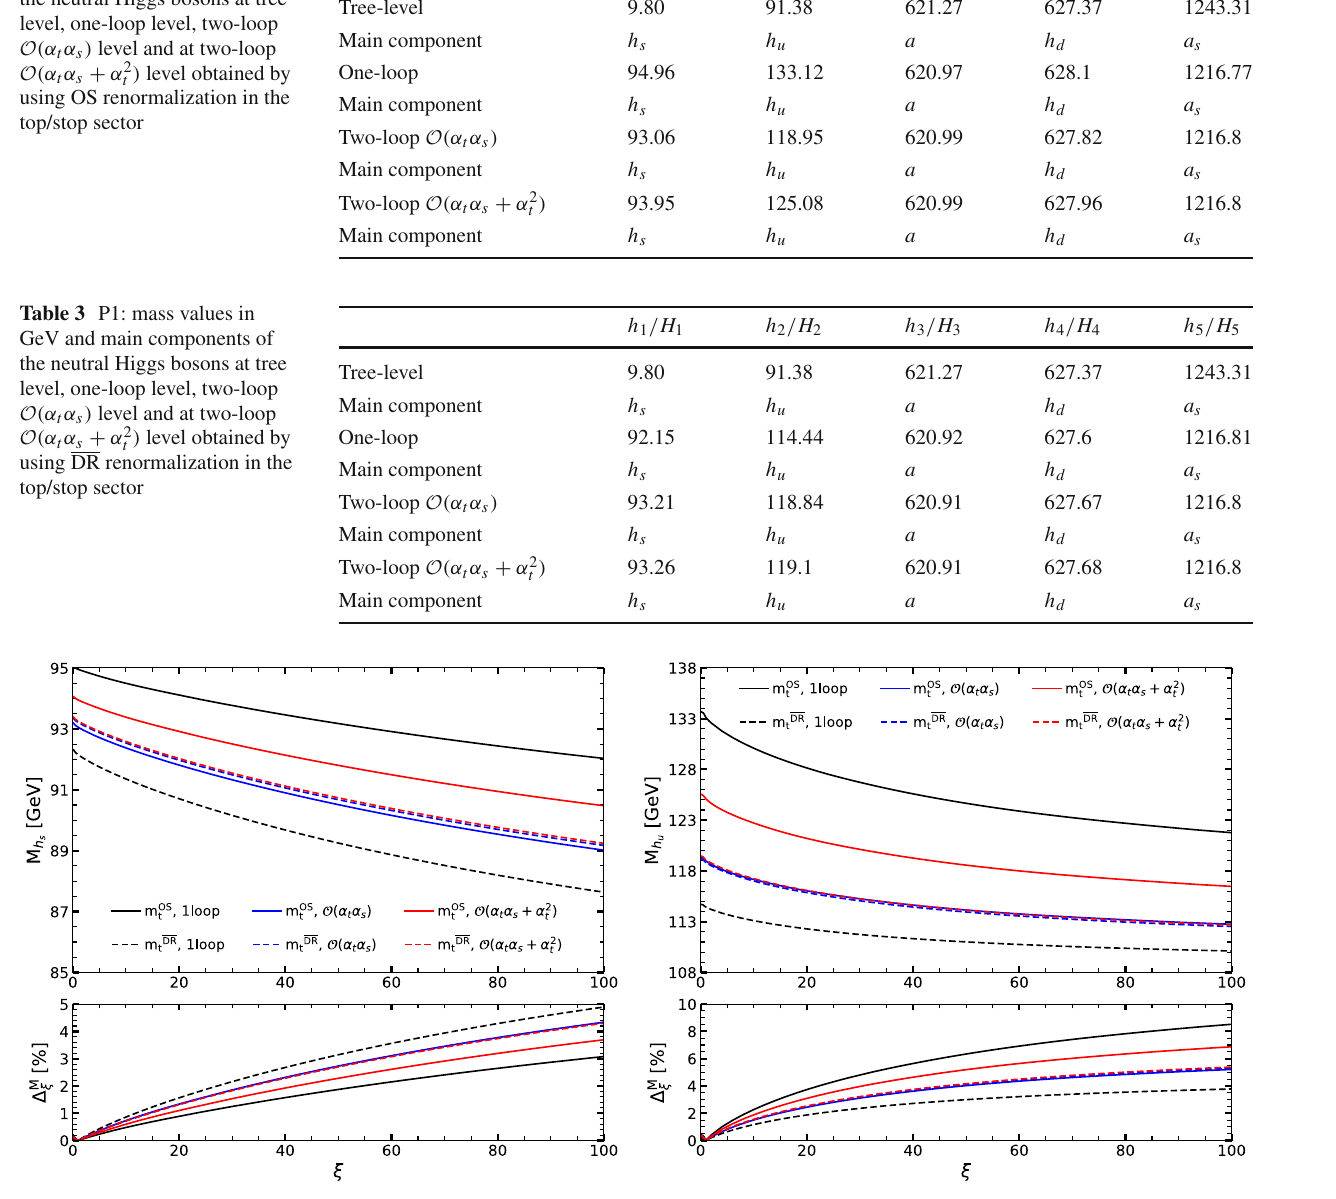
Table 2 P1: mass values in GeV and main components of the neutral Higgs bosons at tree level, one-loop level, two-loop α ) level and at two-loop O (α t s α + α 2 ) level obtained by O (α t s t using OS renormalization in the top/stop sector